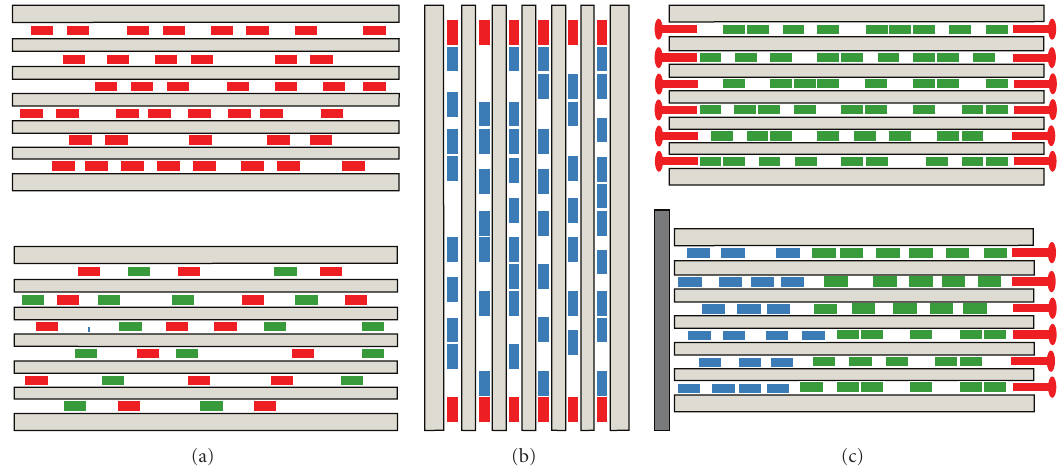
Figure 2: Schematic representations of supramolecularly organized dye-zeolite L systems. (a) Single and mixed dye materials are obtained by either loading zeolite crystals with one kind of dye (top) or by simultaneous insertion of di ff erent dye molecules (bottom). (b) Antenna materials can be prepared by the sequential insertion of di ff erent dyes. (c) Stopcock-plugged antenna material is obtained by modifying either bidirectional (top) or mono directional (bottom) antenna materials with specific closure molecules, called